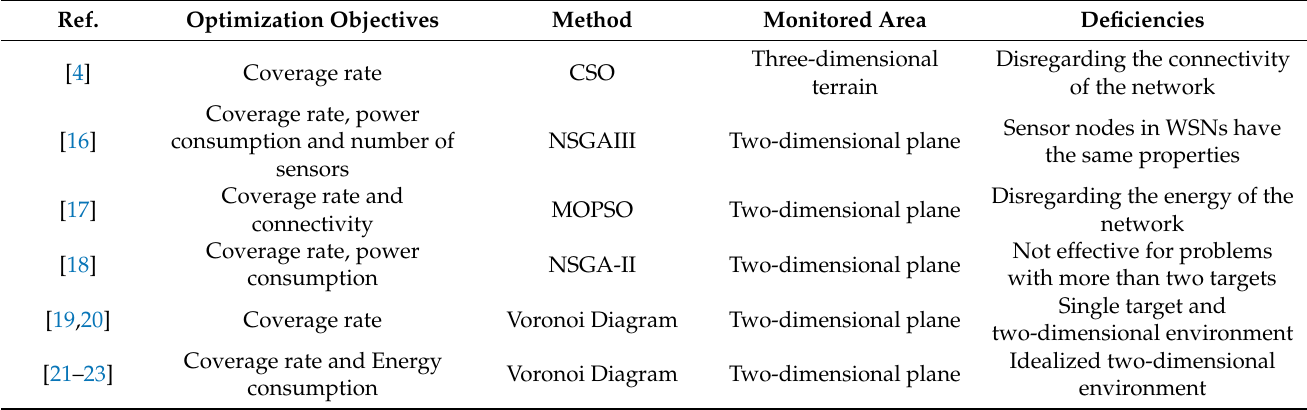
Table 1. Literature review for related